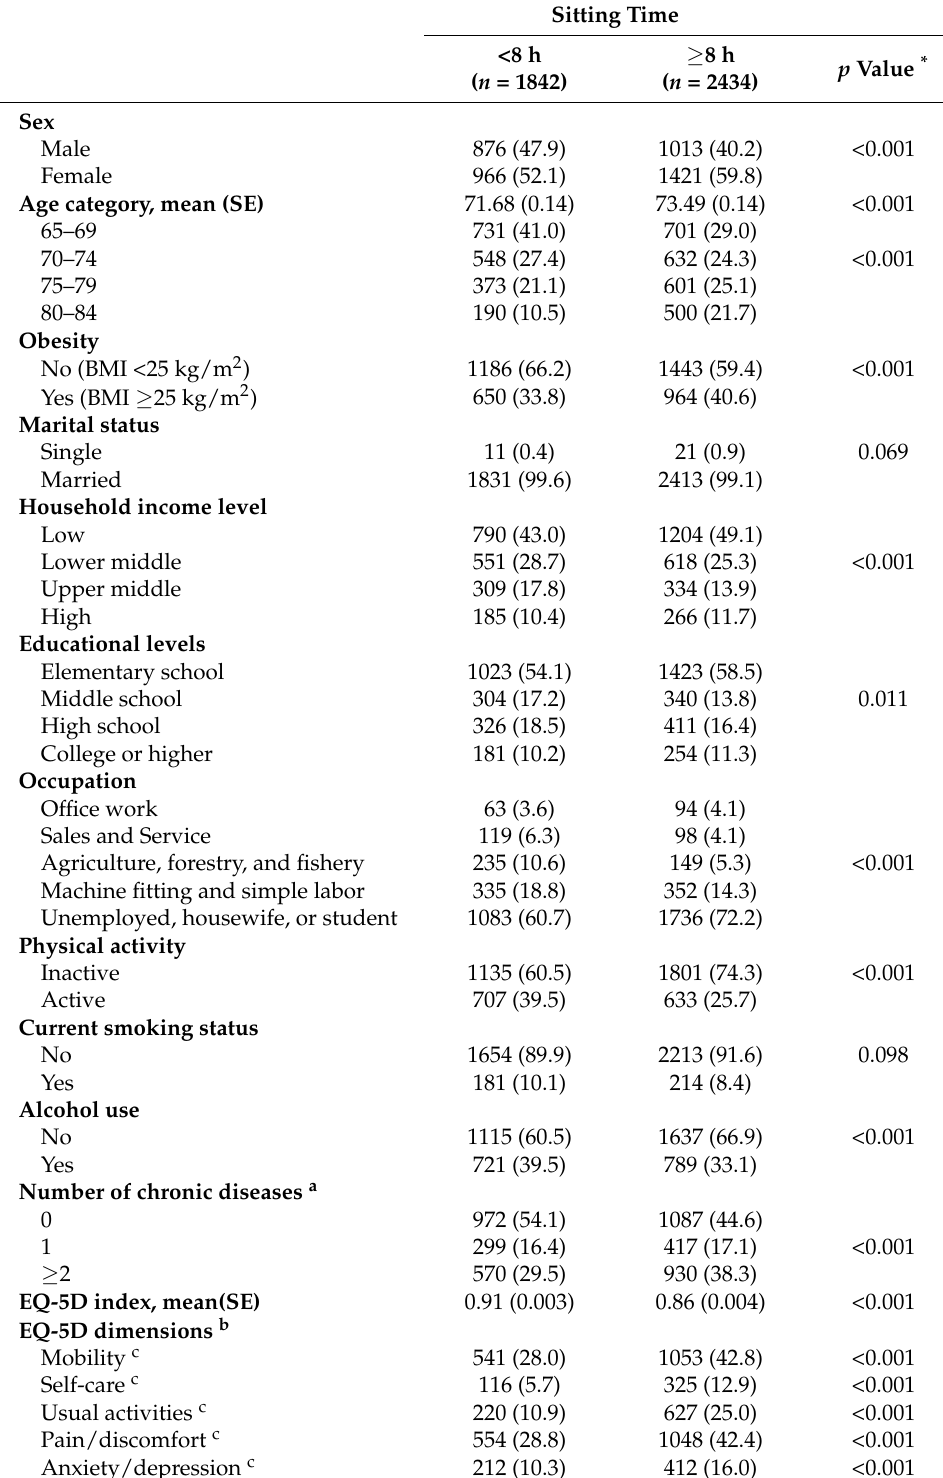
Table 1. Baseline characteristics stratified by sitting time ( n =